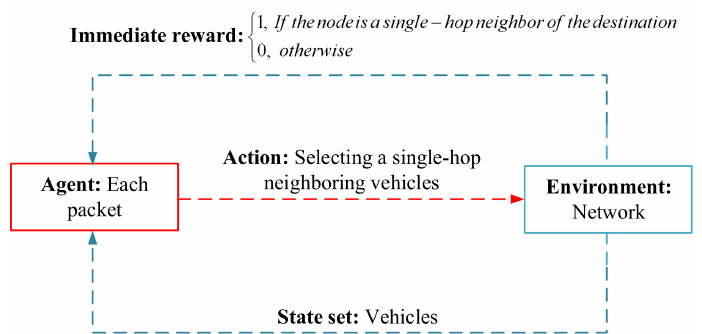
Figure 12. Learning structure in